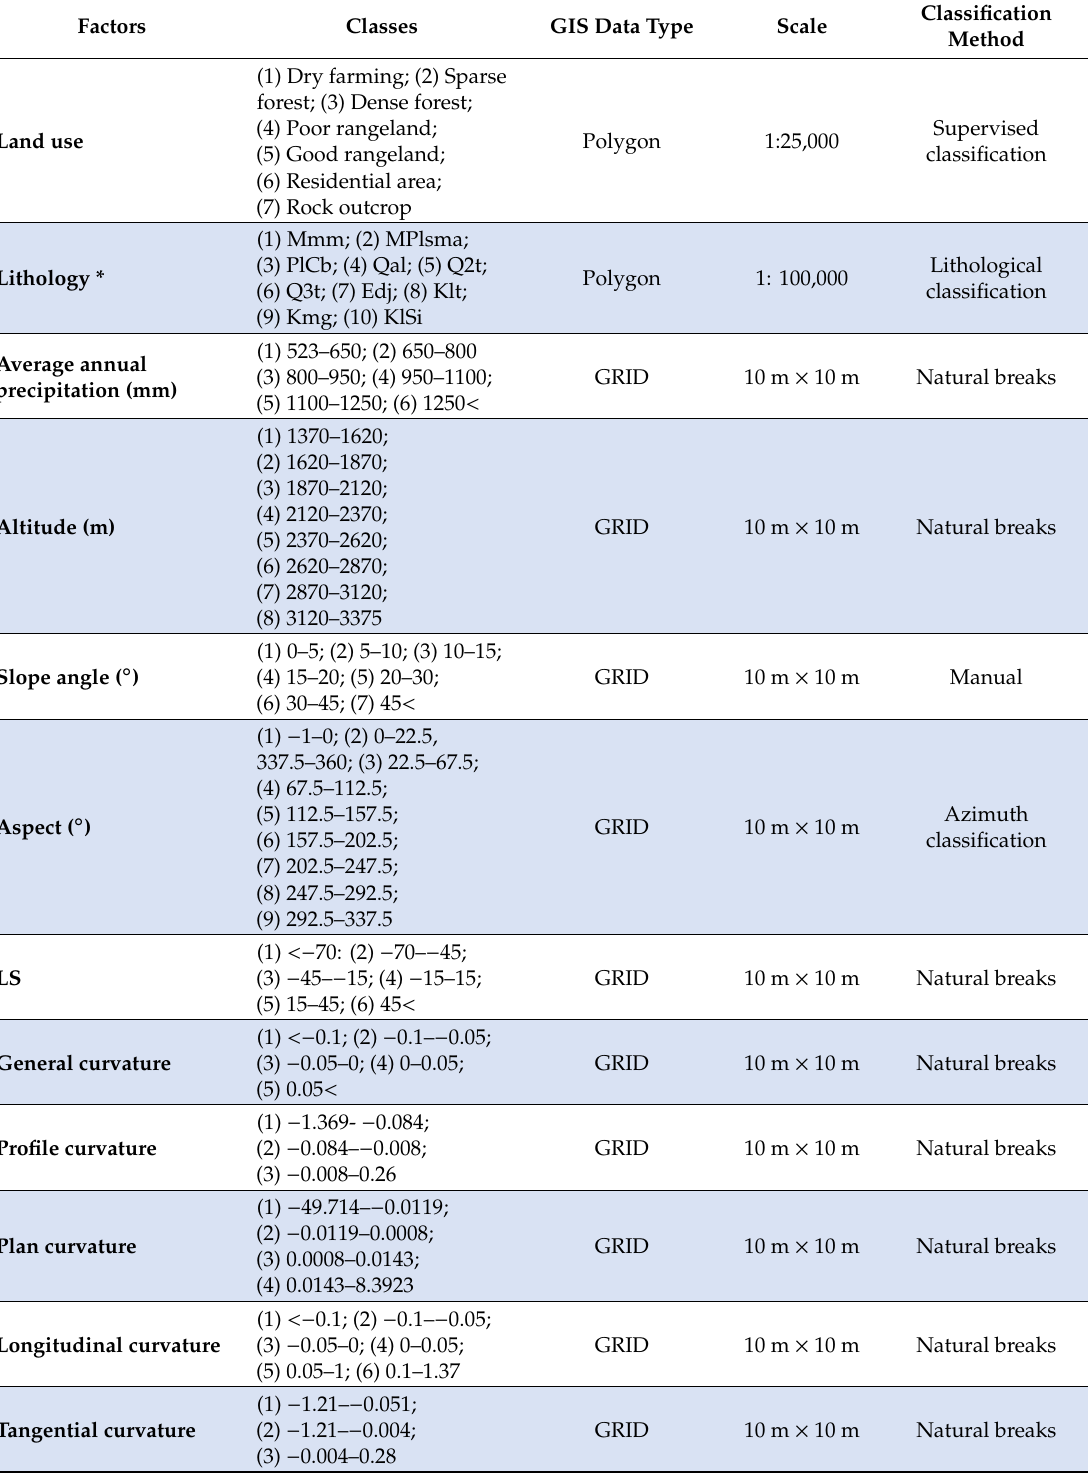
Table 1. Landslide conditioning factors and their